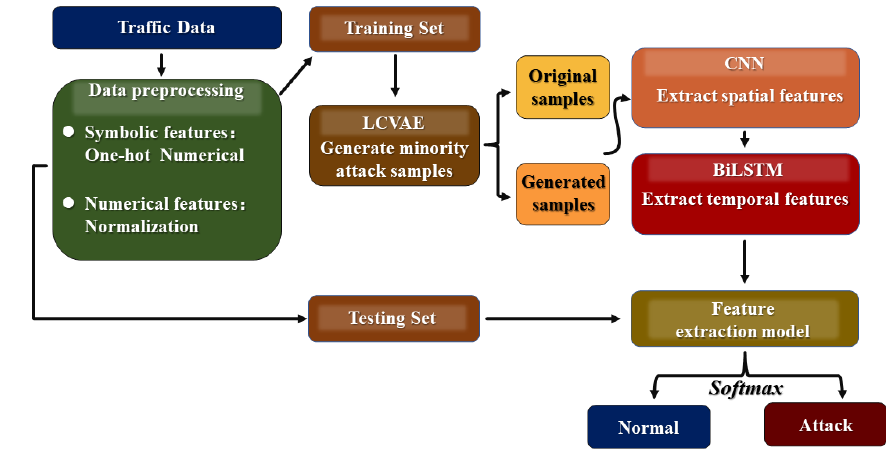
Figure 2. Flow chart of the LCVAE-CBiLSTM